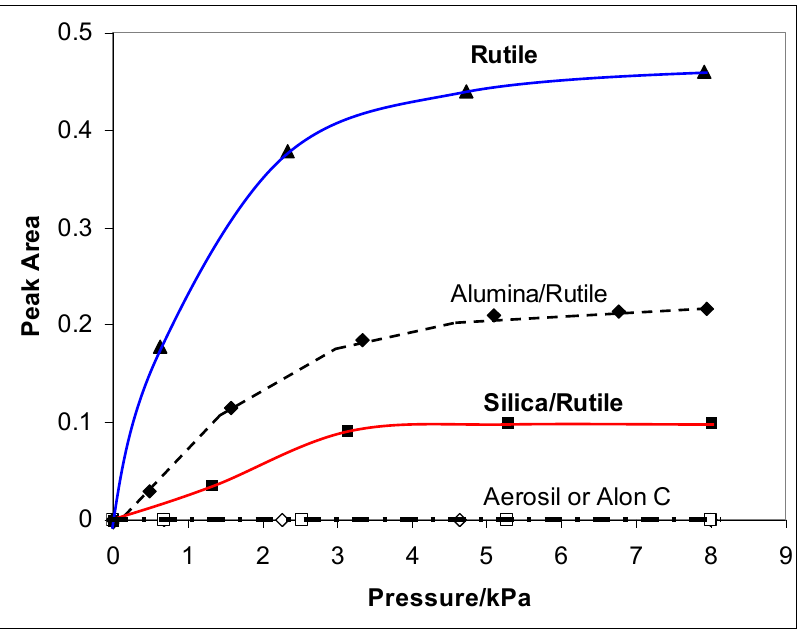
Figure 5. The dependence of the N absorption at 2335 cm − 1 on the presence of 15% 2 alumina or 8.9% silica deposited on the surface of the high area rutile #1. No 2335 cm − 1 absorption was measured on Aerosil or Alon C. All measurements were made at ~ (cid:3398) 150 °C (123